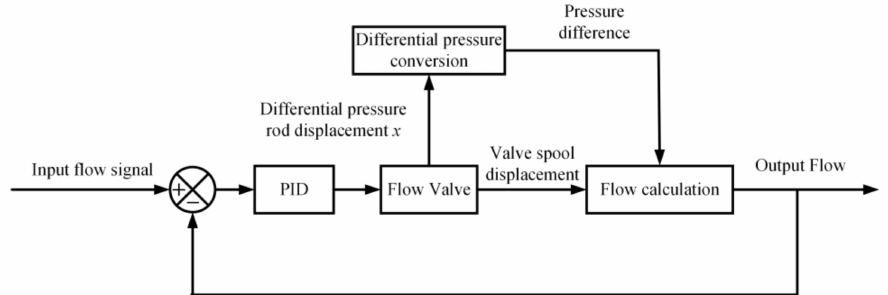
Figure 9. Flow feedback control block